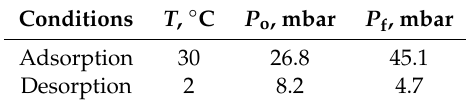
Table 3. Boundary temperature, initial P o and final P f pressures for the dynamic measurements.